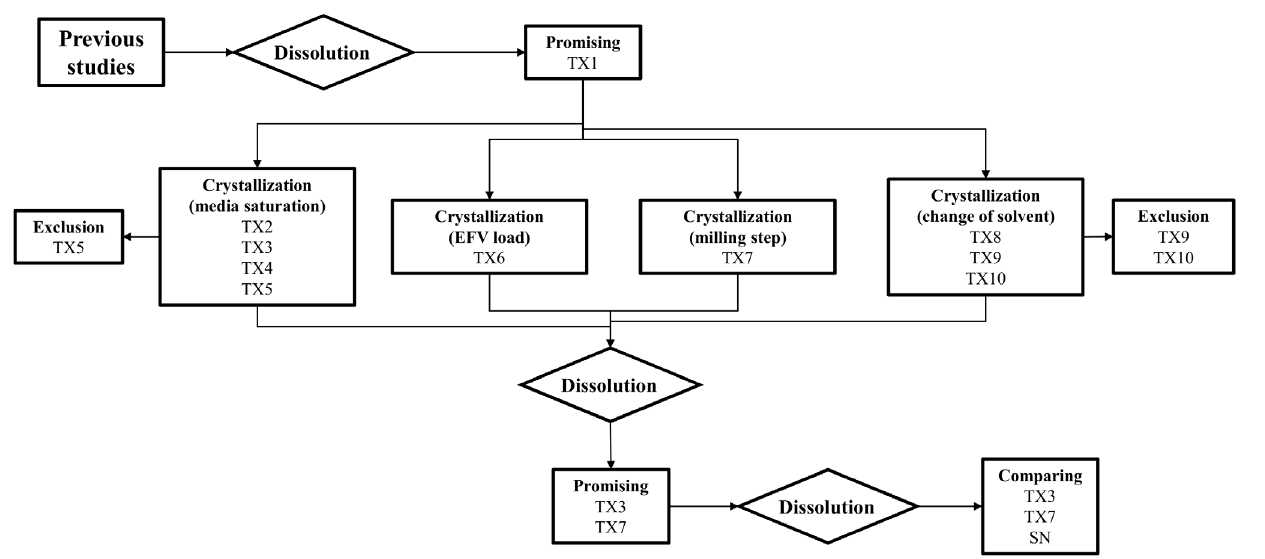
FIGURE 1 - Workflow for the design of the different formulations. Efavirenz (EFV) nanocrystallization experiments presented step-by-step. Samples were considered promising or excluded based in the dissolution assay, hence this test was in a diamond TABLE I - E xperimental parameters used in the preparation of the samples